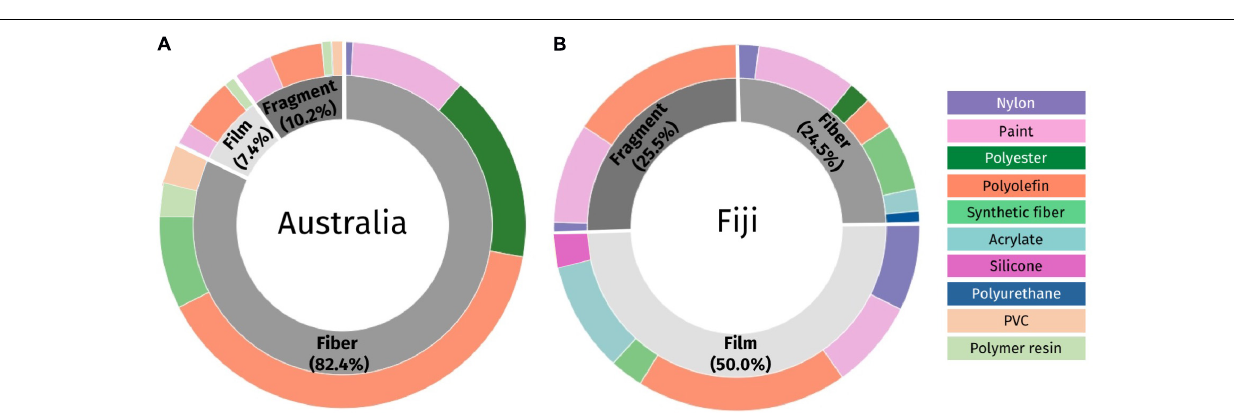
FIGURE 6 | Different types of microplastic found in the gastrointestinal tract of fish in Australia (A) and Fiji (B) . The inner layer shows the plastic types identified under the microscope (fiber, fragment, and film) in shades of gray; the outer layer shows the plastic polymer groups confirmed using the µ -FTIR ( Supplementary Table 1